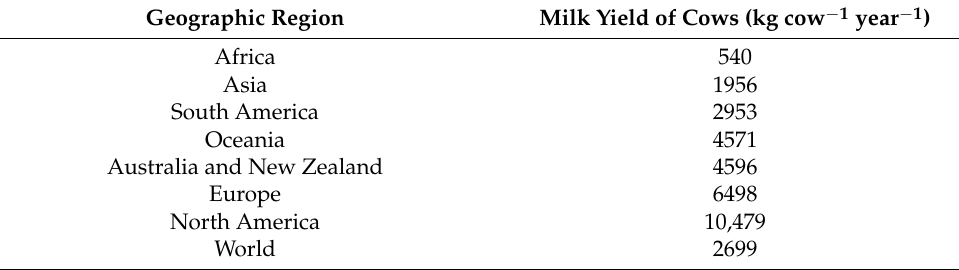
Table 4. Milk yields achieved in geographic regions in 2019